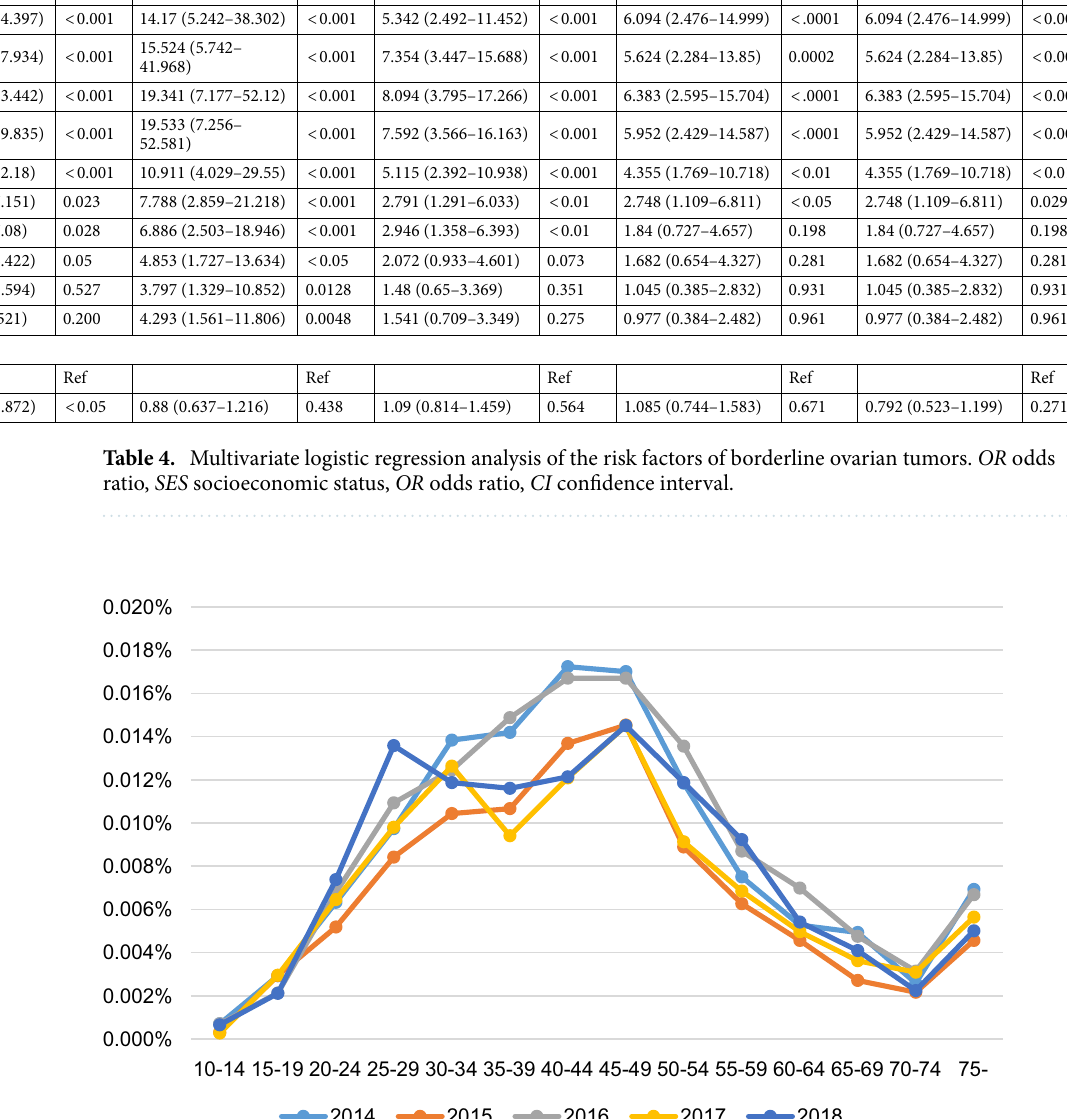
Figure 2. The serial trends in the prevalence of BOT from 2014 to 2018 stratified according to 5-year age